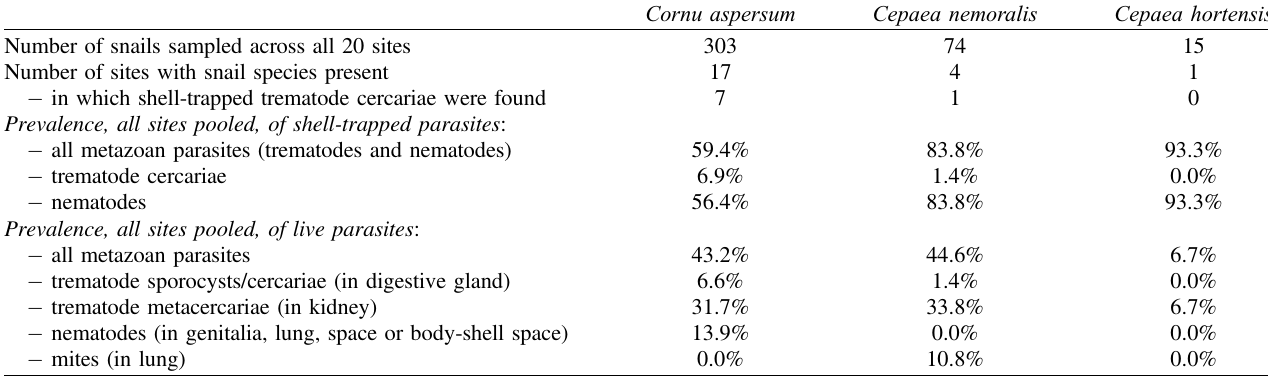
Cornu aspersum Cepaea nemoralis Cepaea hortensis